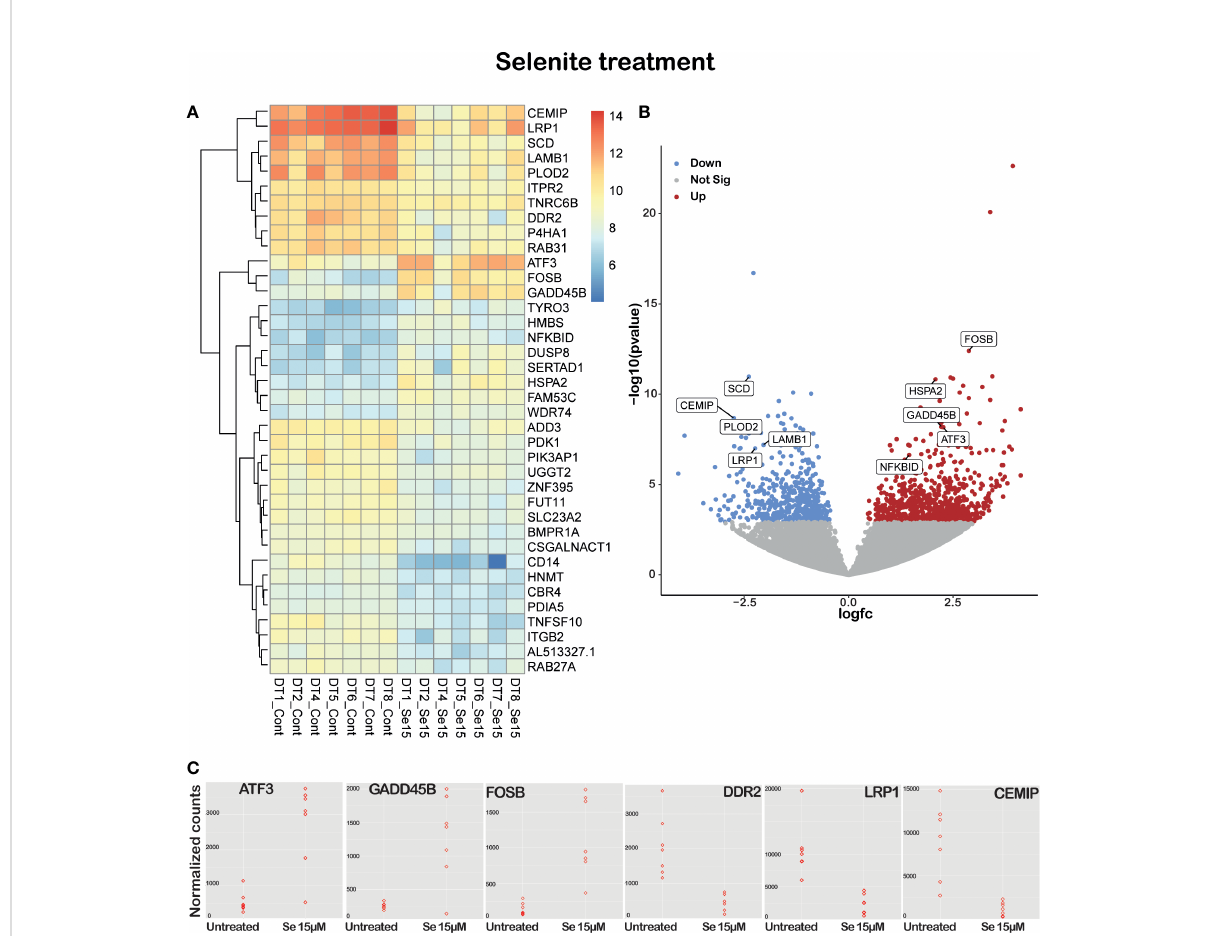
FIGURE 5 Sodium selenite targeting genes in ex vivo cultured tissue slices of human PDAC. (A) Supervised hierarchical clustering with RNA expression heatmap. (B) Volcano plot of signi fi cant differentially expressed/labeled genes between untreated and 15 µM sodium selenite treated tissue slices. (C) Dot plot of several relevant differentially expressed genes between untreated and 15 µM sodium selenite treated samples